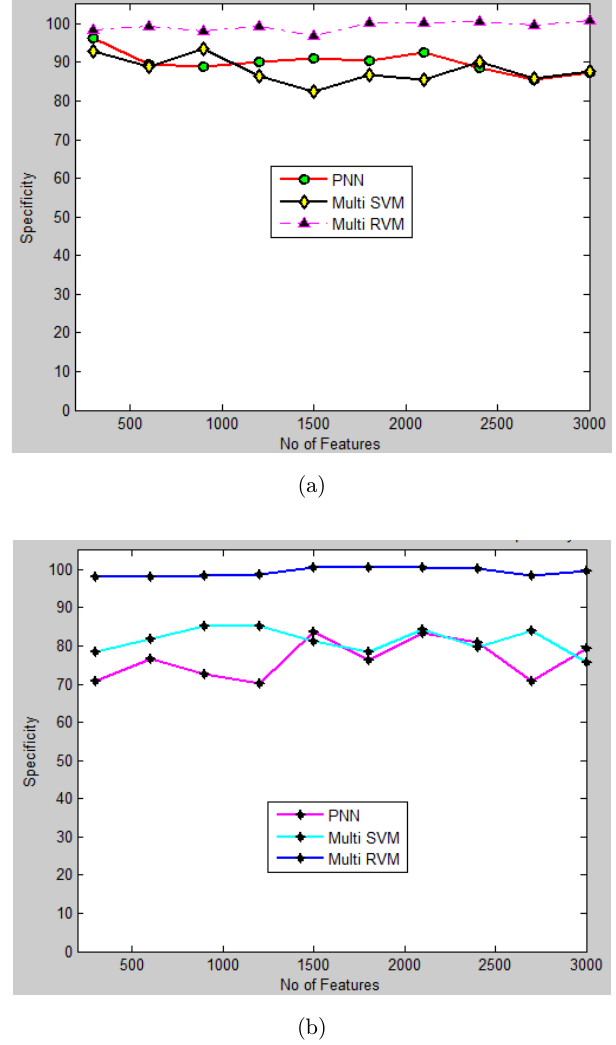
Fig. 14. (a) and (b) Comparative Analysis of speci¯city for M-RVM, PNN and Multi-SVM approaches.